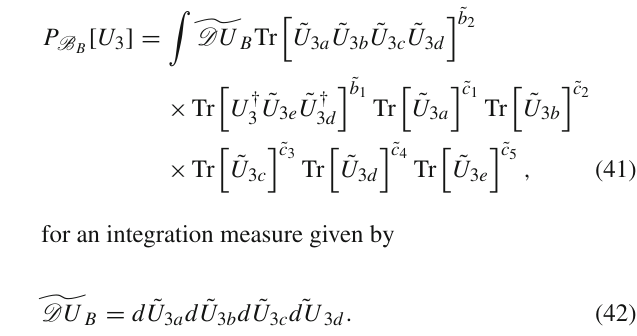
is determined by the values of the G ( l ) ˜ ˜ ] of U μ ( x ) and of its U 3 e U † ν 0 3 3 d 0 0 ˜ ˜ ˜ ˜ U 3 a U 3 b U 3 c U 3 d ] . The group integration